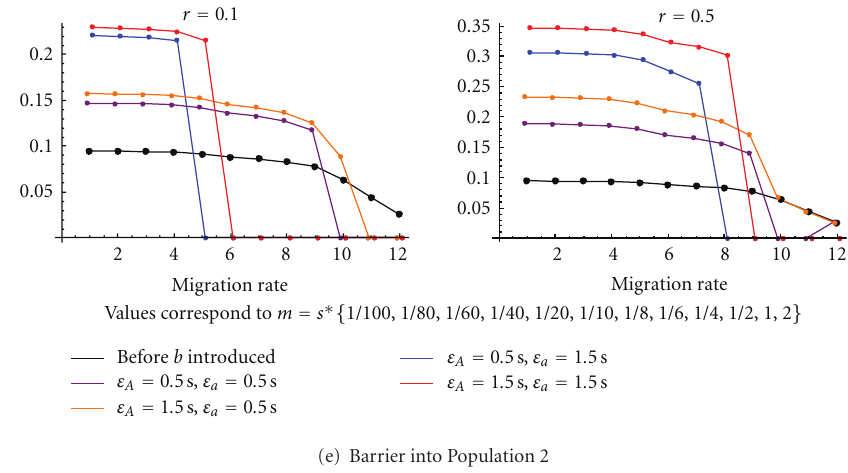
Figure 2: Numerical simulation results for the epistatic trade-o ff model (Case 1). Various properties are shown as a function of the migration rate, expressed relative to the strength of ecological selection on the A locus, s . The migration rates numbered 1–12 correspond to m = s ∗ { 1 / 100,1 / 80,1 / 60,1 / 40,1 / 20,1 / 10,1 / 8,1 / 6,1 / 4,1 / 2,1, 2 } ; migration is symmetric, that is, m black represent values prior to the evolution of the modifier (i.e., assuming both populations fixed for the B allele as shown in Time 1 in Figure 1). Colored points represent values after the evolution of the modifier; di ff erent colors correspond to modifiers of varying e ff ects (see legend). Left column: moderate linkage r = 0 . 1; right column: no linkage: r = 0 . 5. (a) Divergence at A locus. (b) Divergence at B locus. (c) Intrinsic isolation as measured by the average fitness individuals from Populations 1 and 2 compared to the average fitness of F 2 hybrids. (d) Strength of the barrier into Population 1. (e) Strength of barrier into Population 2. Parameter values used: s = s 1 = s 2 = 0 . 1; t 1 = t 2 = 0. See text for